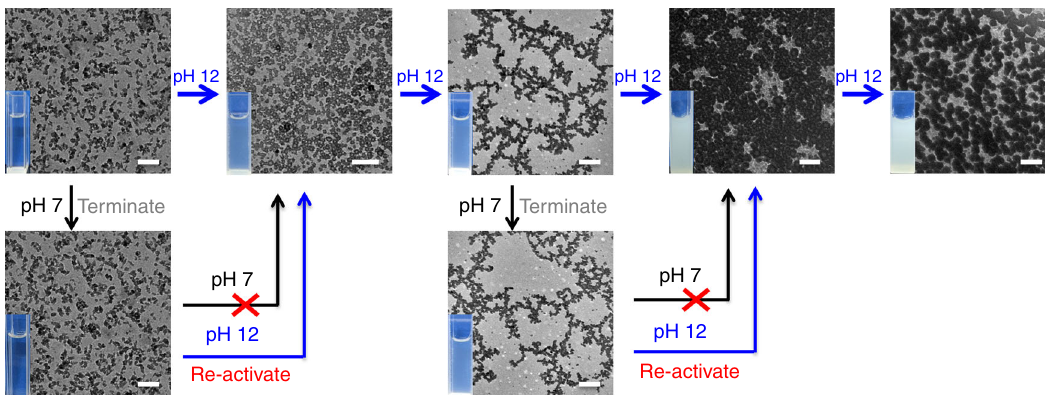
Fig. 10 pH-Switched morphology evolution. TEM images showing in situ morphology evolution with termination and reactivation function under the control of system pH. Scale bars: 0.5 μ m. During the whole morphology transition process, once the thiol – disul fi de exchange reaction is interrupted by neutralization at any time, the self-assemblies, including cylinders, vesicles, worm-like micelles, hollow spheres, etc. at that moment are fi xed and kept stable for more than 7 days, but this morphology and size evolution is easily restarted and returned back on its right track by reactivation of the exchange reaction at pH 12 solutions. This whole self-assembled evolution process can be easily activated, controllably terminated and interrupted, and reinitiated by the external pH stimuli whenever needed. The inset shows that the assembled solution in the quartz plate is changed from transparency to